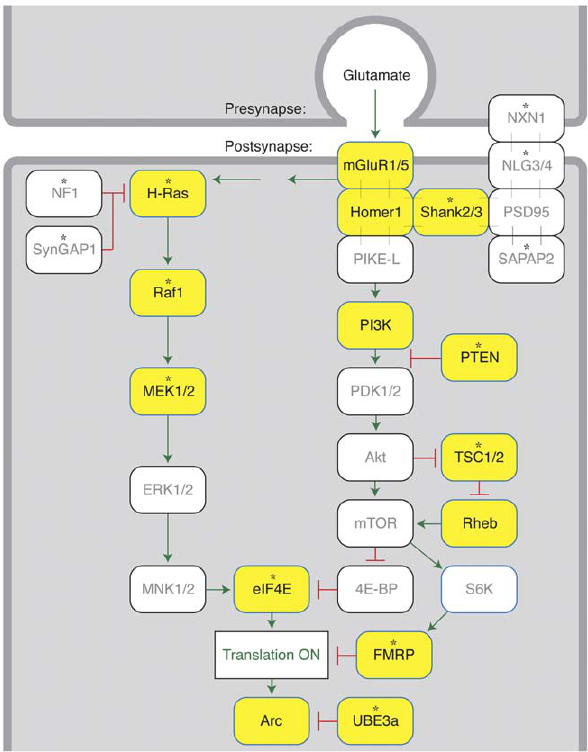
Figure 1. The mGluR pathway coupling synaptic activity to synaptic protein synthesis. The diagram illustrates components and interactions in the mGluR pathway [4]. Genes encoding proteins highlighted in yellow were sequenced in this study. Activation of postsynaptic group 1 mGluRs (mGluR1, mGluR5) stimulates protein synthesis by signaling through the Ras/ERK and PI3K/mTOR pathways. Group 1 mGluR function is modulated by interaction with Homer1, which interacts in turn with Shank3 and links mGluRs to the network of postsynaptic density-localized proteins. FMRP regulates synaptic protein synthesis by binding to target mRNAs and repressing their translation. Arc regulates mGluR-dependent synaptic plasticity, and its levels are regulated by FMRP-dependent translation and Ube3a- dependent degradation. The activity of the mGluR pathway is regulated by several pathway components responsible for syndromic ASDs (indicated by asterisks), including NF1 (neurofibromatosis type 1), Ras/ ERK cascade members (cardiofaciocutaneous/Noonan syndromes), PTEN (ASD with microcephaly), TSC1 and TSC2 (tuberous sclerosis complex), FMRP (fragile X mental retardation syndrome), and Ube3a (Angelman’s syndrome). Mutations in Shank3, Nrxn1, Nlgn3, and Nlgn4 cause rare non-syndromic ASDs, and structural variants in SynGAP1 and DLGAP2/SAPAP2 have been associated with autism (indicated by asterisks)